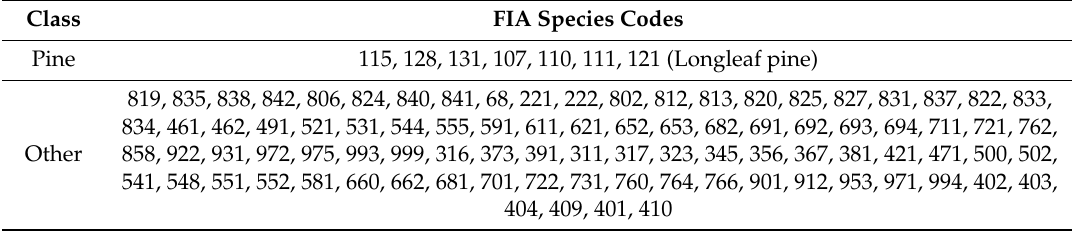
Table A2. Landsat 8, Sentinel 2, and Aerial image acquisition dates by season and path, row, or tile. Source